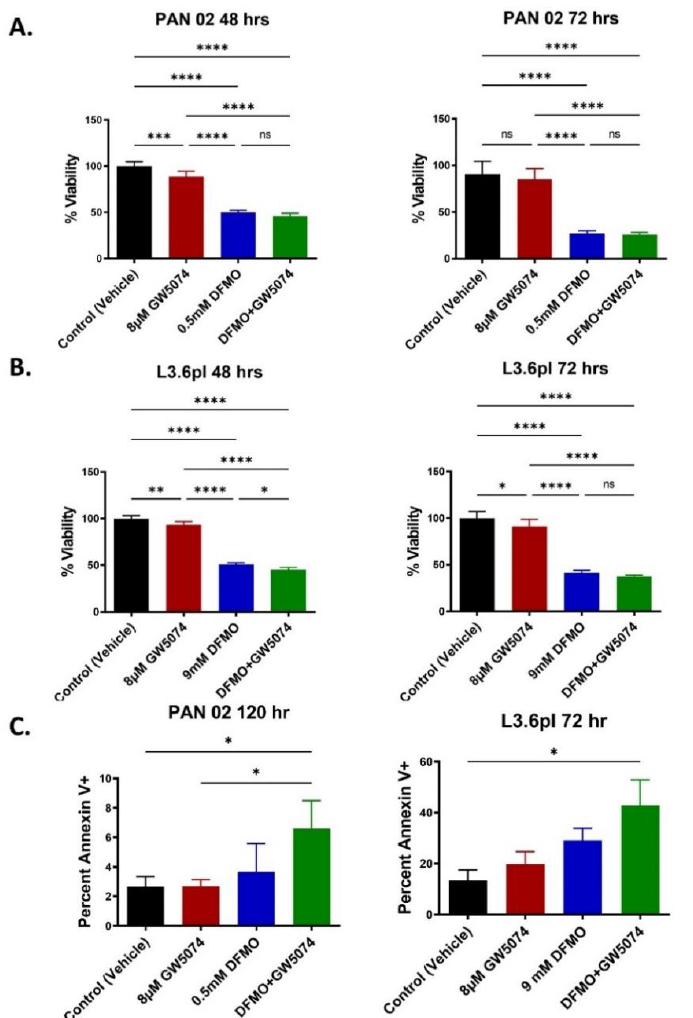
Figure 1. DFMO and DFMO + GW5074 inhibit pancreatic cancer cell viability in vitro. ( A ) The relative growth of PAN 02 cells treated with control, GW5074, DFMO and DFMO + GW5074 for 48 and 72 h were assessed by the MTS assay. ( B ) The relative growth of L3.6pl treated with control, GW5074, DFMO and DFMO + GW5074 for 48 and 72 h were assessed by the MTS assay. ( C ) Flow cytometry analysis of Annexin V+ PAN 02 cells treated for 120 h and L3.6pl cells treated for 72 h revealed a significant increase in apoptotic cells in the DFMO + GW5074 treatment with respect